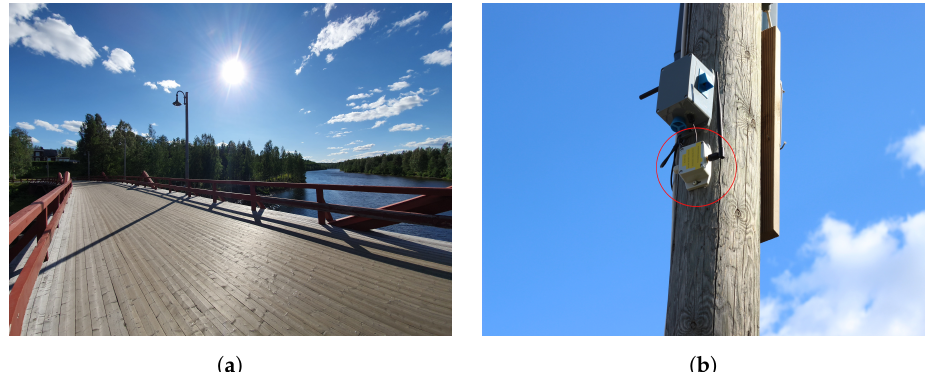
Figure 4. Wooden bridge and E1 sensor close-up. ( a ) Wooden bridge (Lejonströmsbron). ( b ) Close-up of E1 sensor.